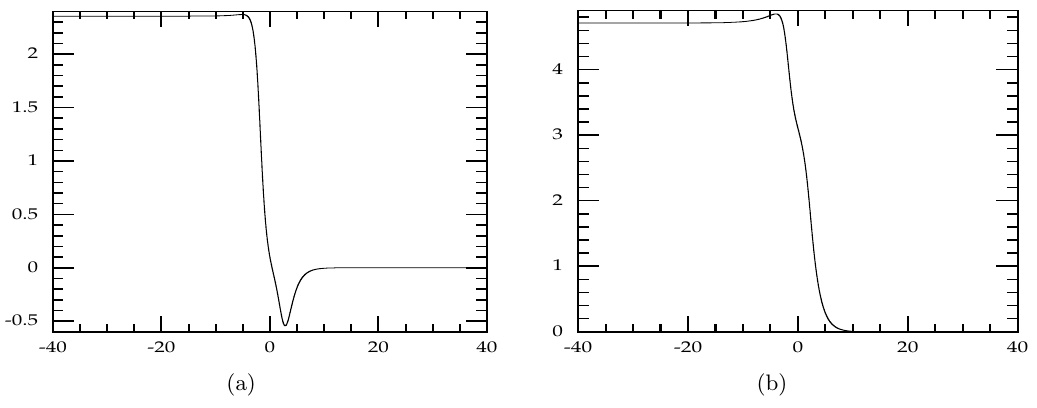
Figure 11 . SU(3) (cid:12)elds | case IV; a) (cid:12)elds ’ 1 and ’ 2 . This case is similar to I but (cid:21) = 1 :